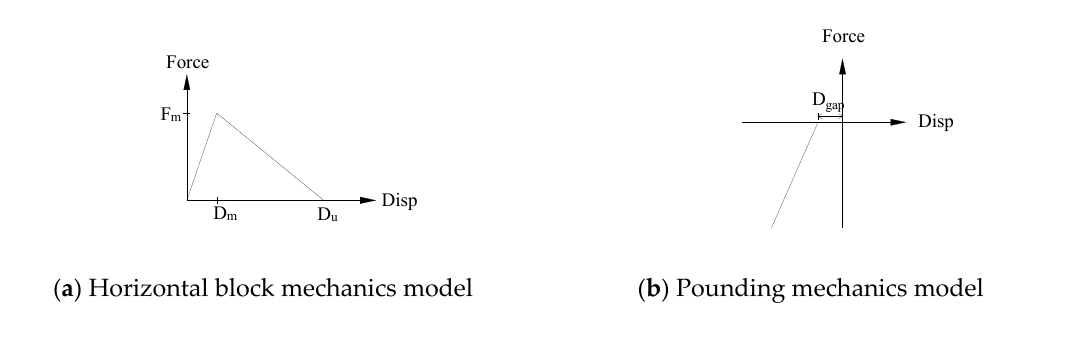
Figure 7. Bridge model.